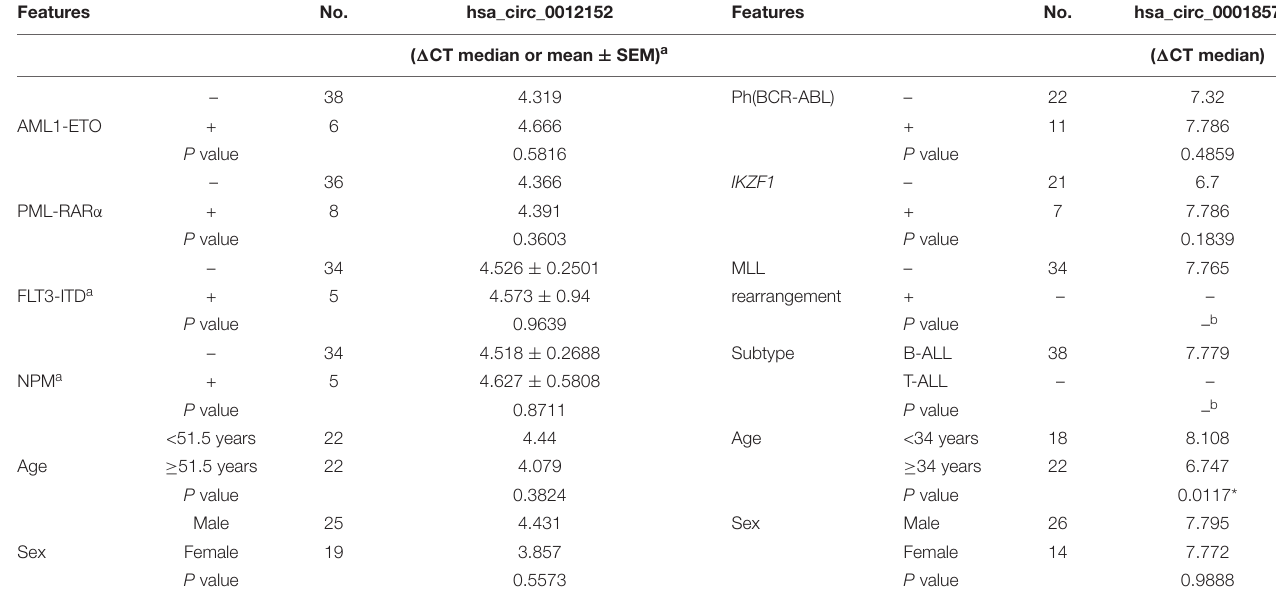
TABLE 1 | Expression of hsa_circ_0012152 and hsa_circ_0001857 in subtypes of acute myeloid leukemia (AML) and acute lymphoblastic leukemia (ALL).